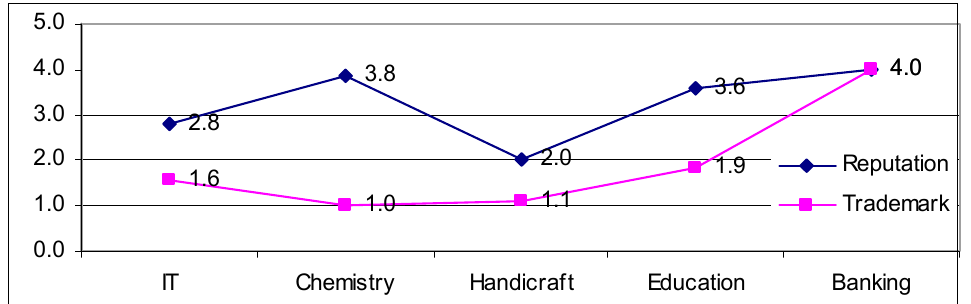
Figure 1. The divergence between the importance of reputation and of trademark registration by industries.